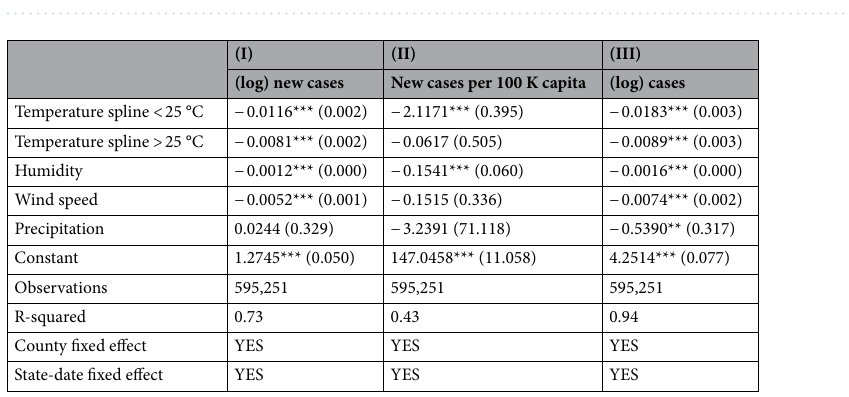
Figure 1. The effect of temperature and wind speed is significantly negative across different delay specifications. The outcome variable is (log) new cases. The x-axis shows different values of the delay time between 0 and 14 days. Standard deviations of the OLS estimations are based on robust standard errors clustered at the county level. Country and state-date fixed effects applied. N = 1,207,317.